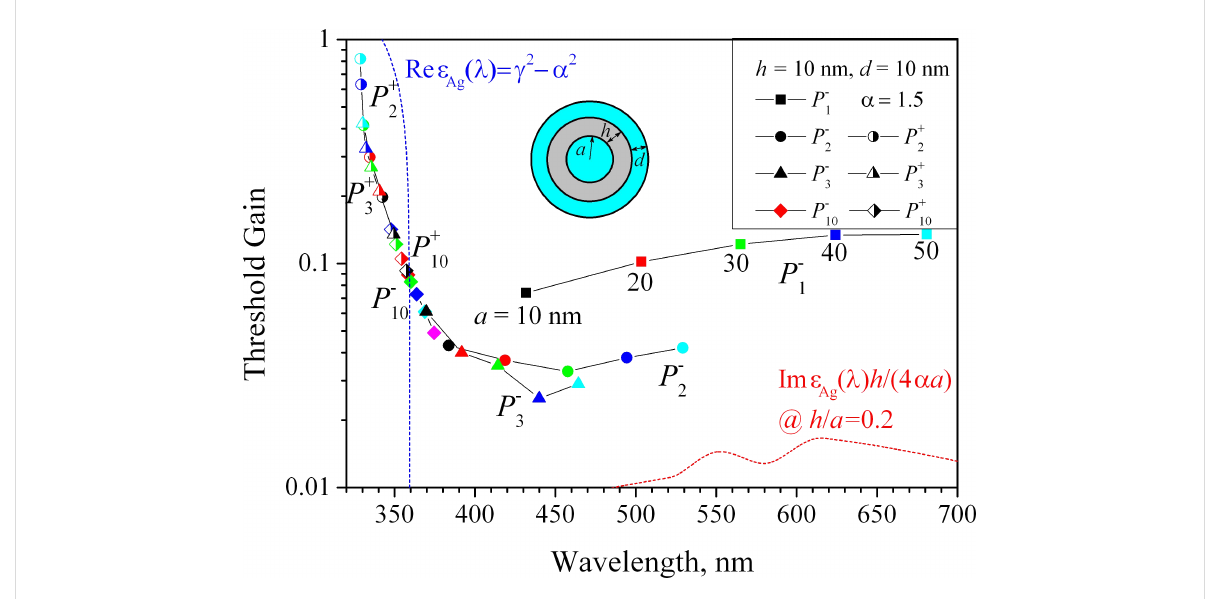
Figure 6: The trajectories of the eigenvalues of lasing modes on the plane ( λ , γ ) for a plasmon nanolaser with a silver tube thickness h = 10 nm and an active shell thickness d = 10 nm. The active core radius varies from 10 to 50 nm as marked on the trajectories. The dashed curves are the same as in Figure 5.